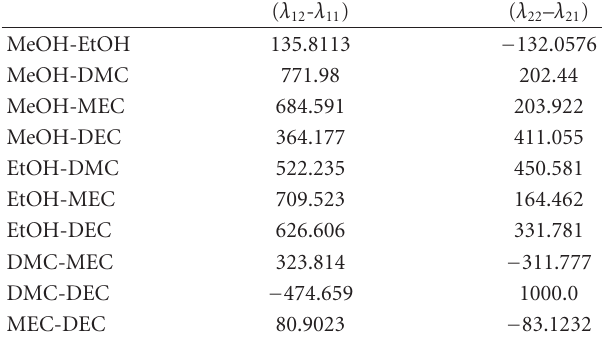
Table 4: Parameters of the Wilson model (cal/mol) [7].